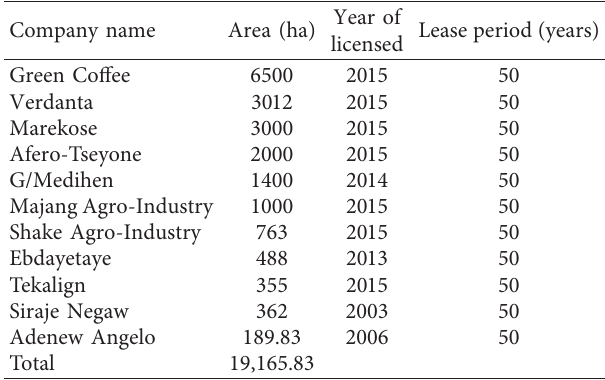
Table 14: Leased land for private companies investment in Majang Zone. Company